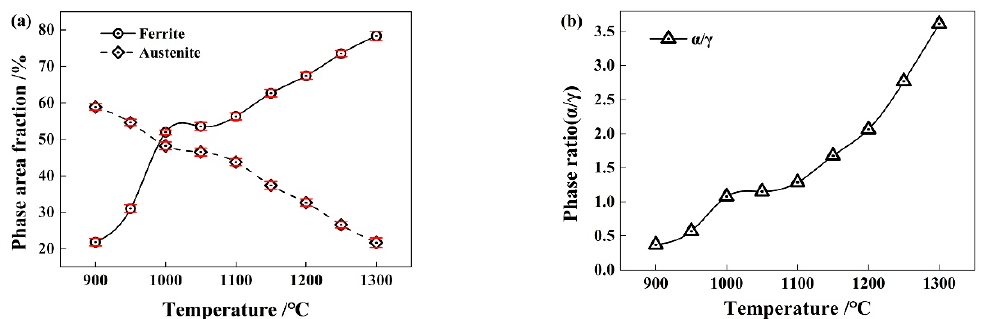
Figure 3. Relationship between solution treatment temperature and ( a ) area fraction of α and γ phase and ( b ) phase ratio ( α / γ ) (error bars represent standard deviation).